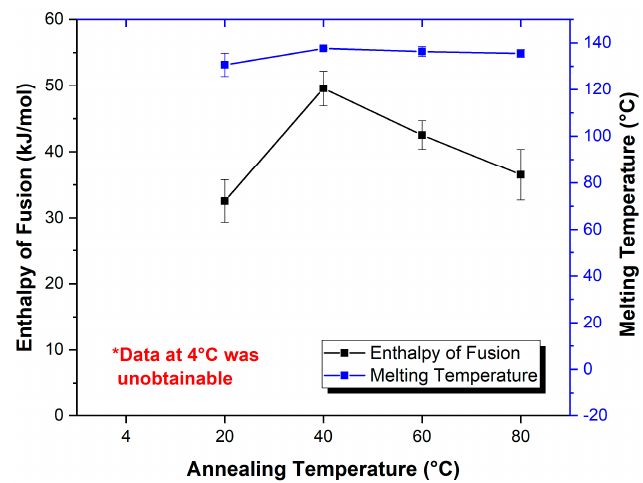
Figure 4. The correlation between the annealing temperature, enthalpy of fusion, and melting point of the VRC-TAR system (t anneal = 3d, n = 3). * A storage temperature of 4 °C produced a gel-like supercooled liquid for which the melting point and enthalpy could not be identified.